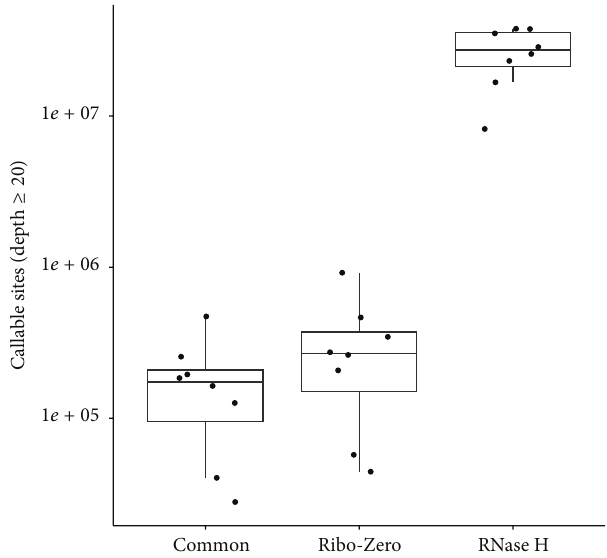
Figure 5: Callable site is defined as a genomic position with depth coverage ≥ 20. The number of callable sites indicates the number of genomic positions that are suitable for SNV inference. RNase H had substantially more callable sites than Ribo-Zero. The percentage of difference in callable site is significantly more than the percentage of difference in number of total reads sequenced by the two kits. 𝑌 -axis is plotted in log 10